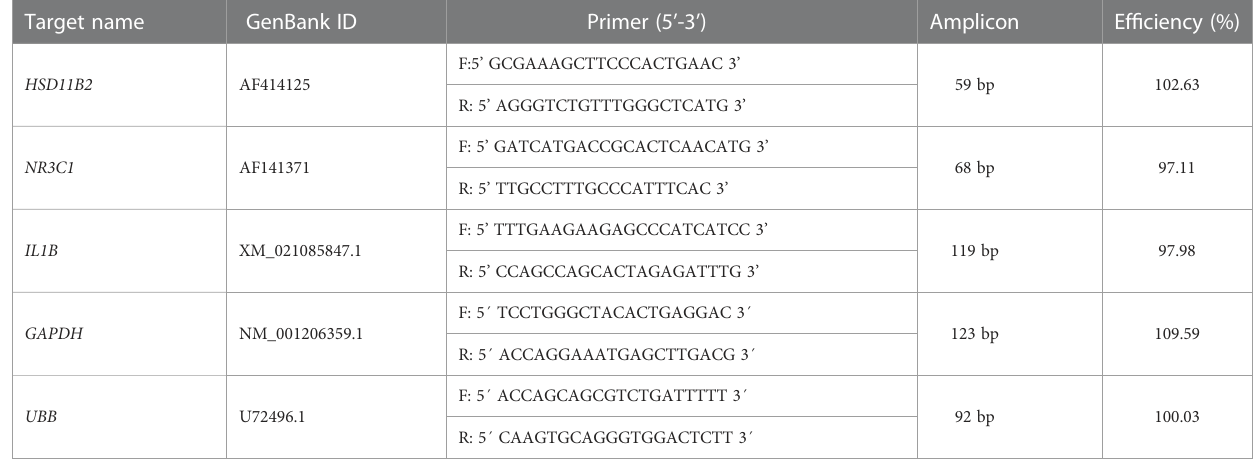
TABLE 4 Swine speci fi c oligonucleotide forward (F) and reverse (R) primer sequence (5 ’ -3 ’ ), amplicon length of the evaluated genes, and primer ef fi ciency in the standard curve on qPCR.